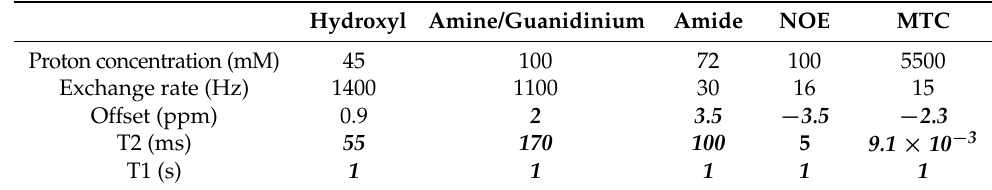
Table 1. List of the starting or fixed values of the parameters used in Bloch fitting. Hydroxyl Amine/Guanidinium Amide NOE